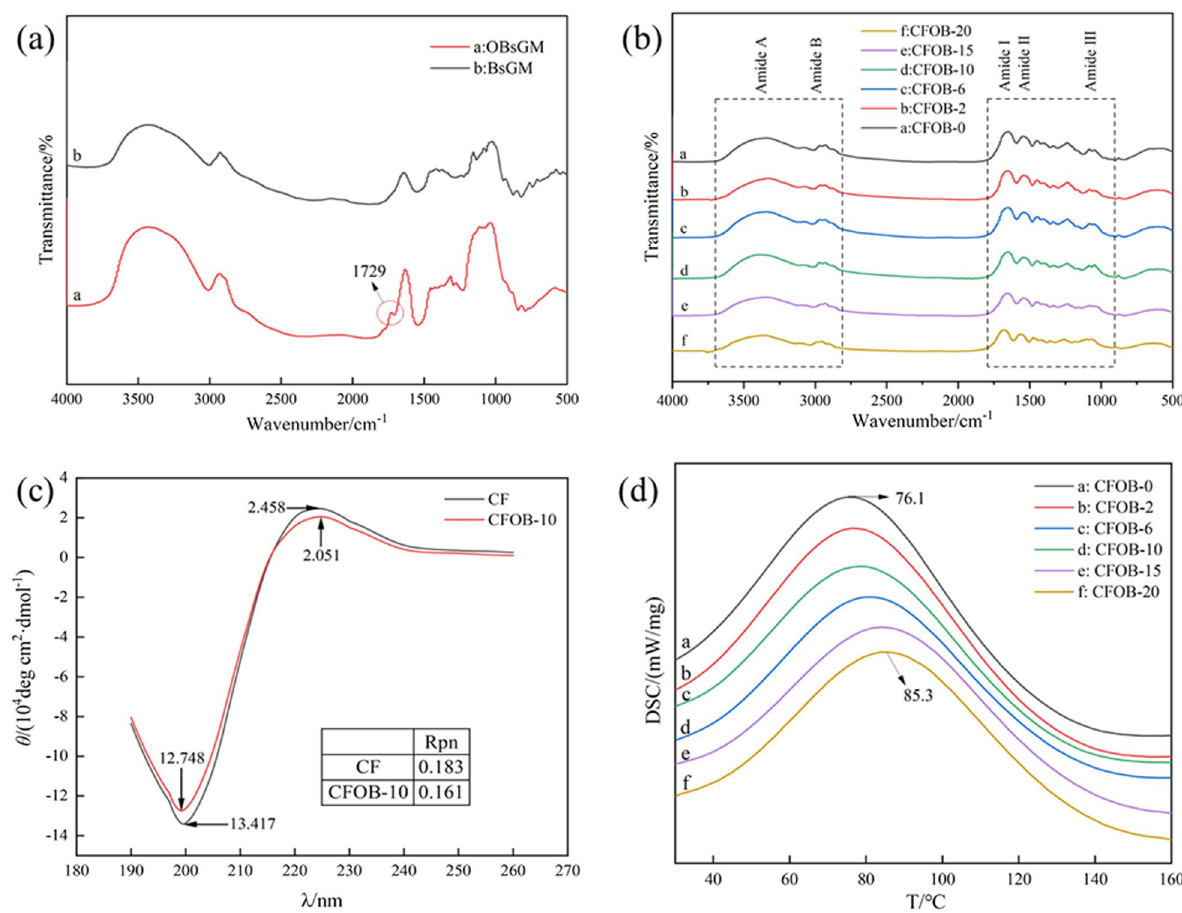
Fig. 1 a Infrared spectra of BSP and OBSP, b infrared spectrum detection diagram of CFOB with different OBSP dosages, c CD spectral analysis diagram of BSP and OBSP, d DSC detection chart of CFOB with different OBSP